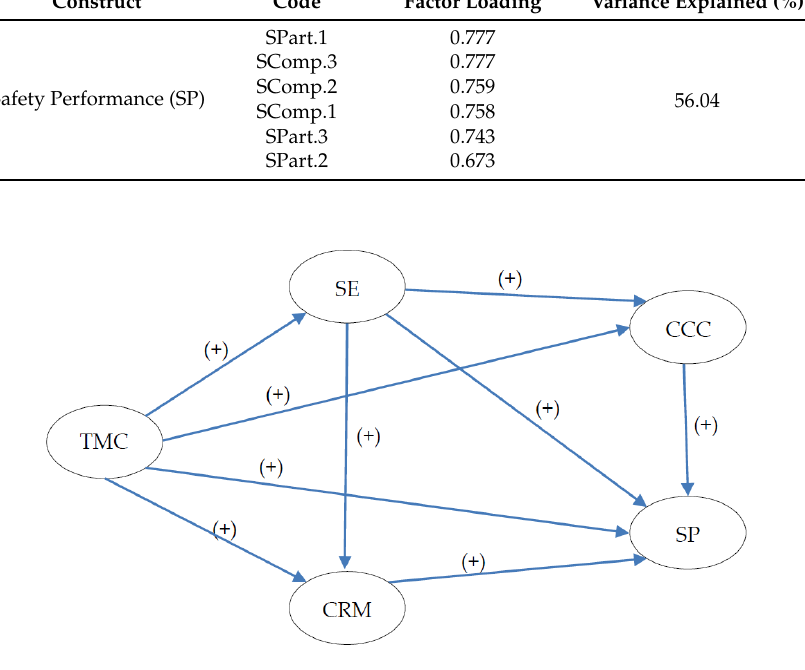
Figure 2. Further development of research model and hypotheses. TMC: top management commitment, SE: supervisors’ expectations, CRM: coworkers’ role models, CCC: coworkers’ caring and communication, SP: safety performance.